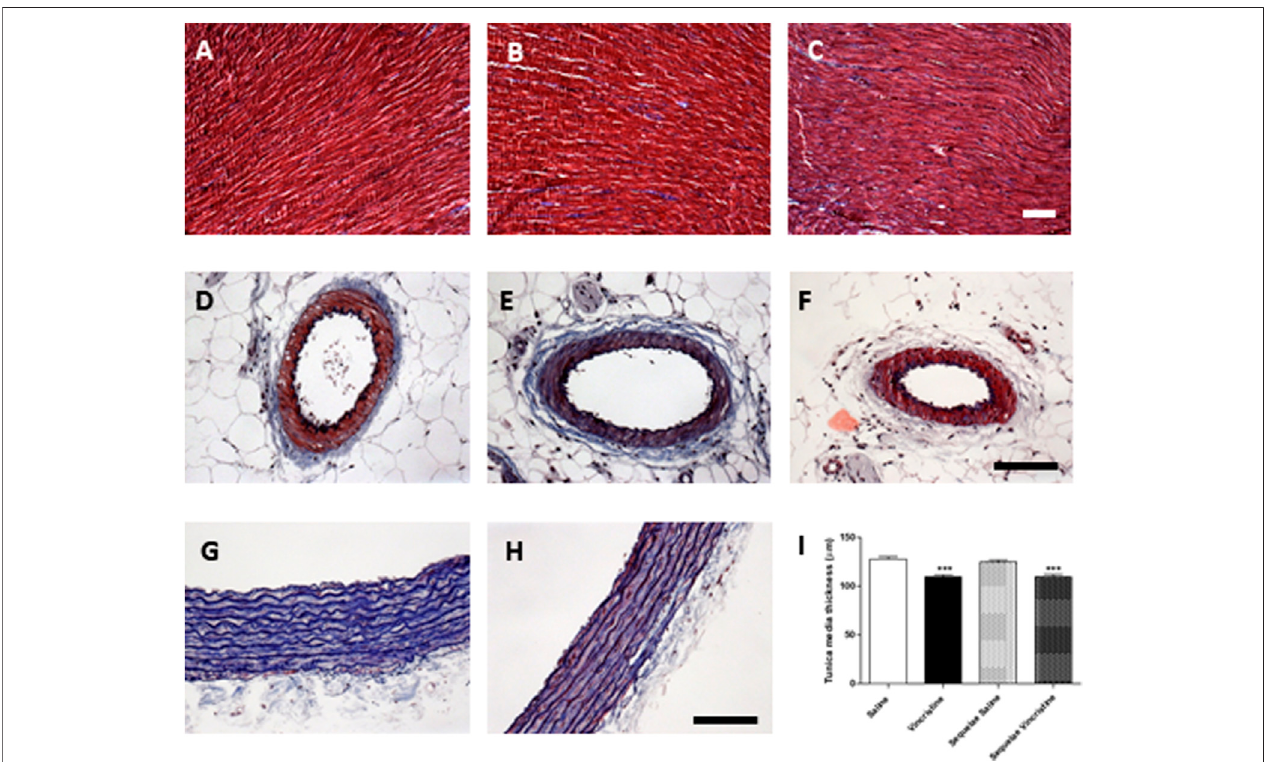
FIGURE10| Effectofvincristineinthestructureoftheheart (A – C) ,mesentericvessels (D – F) ,andaorta (G – I) .Masson ’ strichromestainofsaline (A,D,G) ,animals treated with vincristine (B, E, H) or vincristine-treated animals 2 weeks after treatment (C, F) . Bar: 100 μ m. Mean thickness of the aortic tunica media (I) , obtained from 4 – 6 different animals. Data represent the mean ± SEM. Saline vs. vincristine (*** p < 0.001).